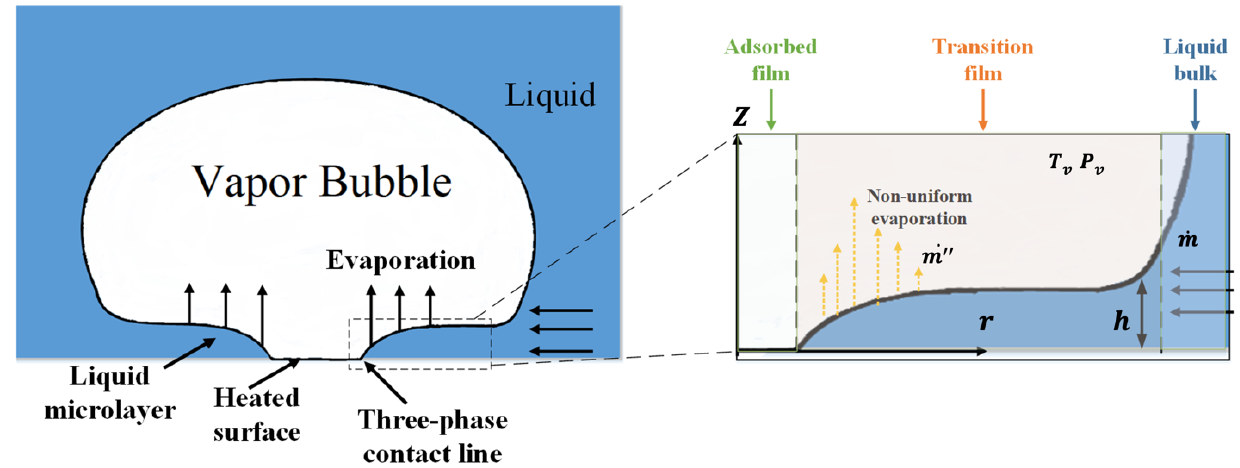
Figure 1. Schematic of an evaporating extended meniscus in the “microlayer” region.